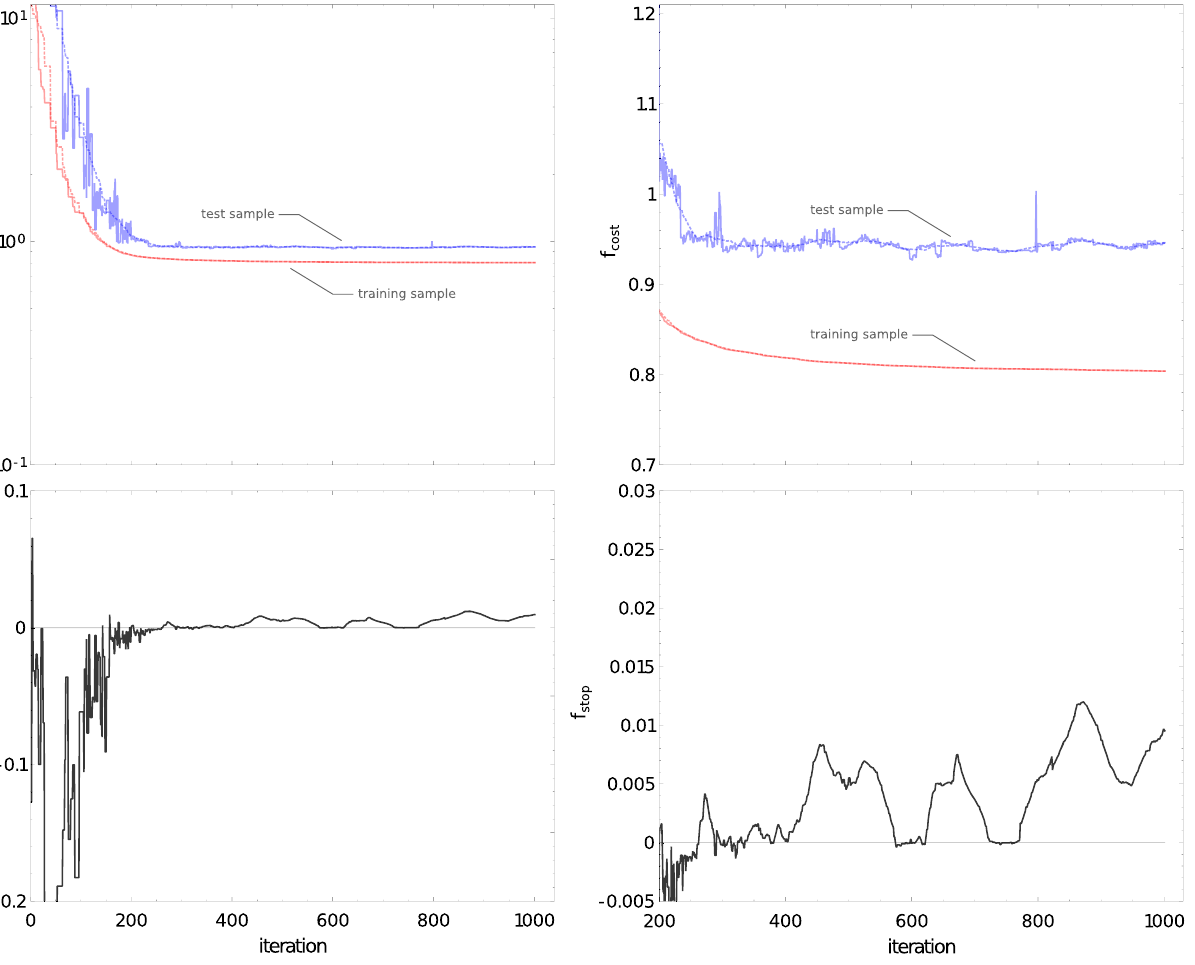
Fig. 9 Cost function (top plots) and f stop quantity (bottom plots) used to detect over-fitting in the regularization method based on the early stoppingtechnique,seeSect.3.3,asafunctionofthetrainingepoch.The left plots show dependencies in the full range of training epoch, while